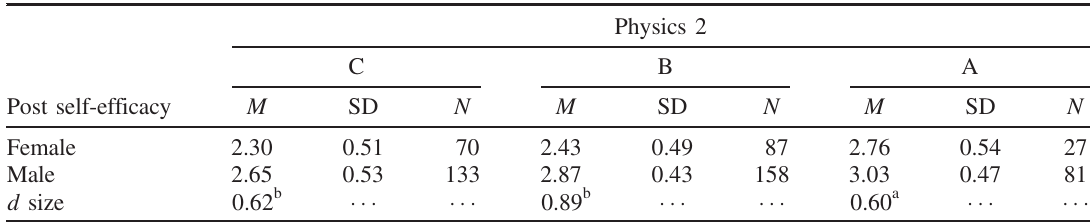
d sizes are Cohen ’ s d values between female and male students ’ self-efficacy scores. a Significant at the 0.05 probability level. b Significant at the 0.001 probability